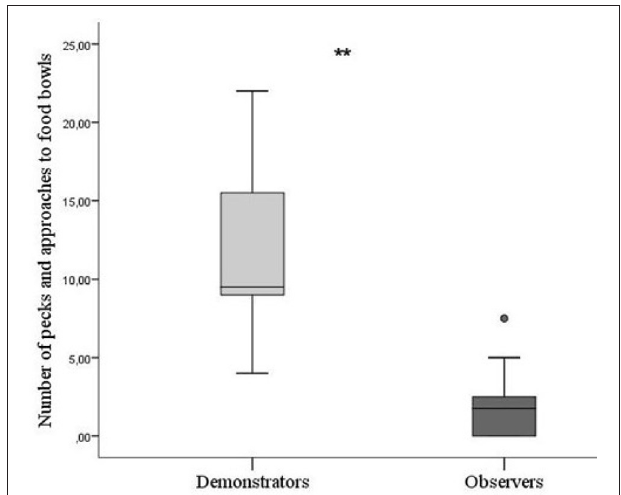
FIGURE 3 | Number of pecks toward food bowls by birds in batch 1. Based on the mean of the two times one bird was tested in each of its pairs. Thick horizontal lines indicates median nr of pecks, boxes span from the first to the third quartiles and the whiskers represent 95% confidence interval; outliers are denoted by dots. Demonstrators ( N = 5) are the light gray bar and observers ( N = 10) dark gray bar (five groups included). The asterisks indicate a significant difference between